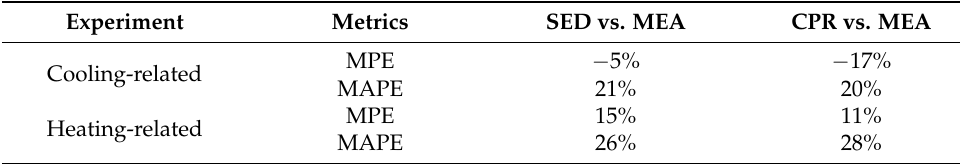
Table 6. Summary of overall